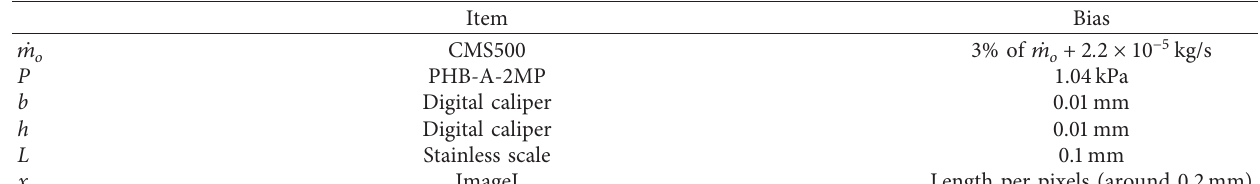
Table 3: Error bias of instrument.